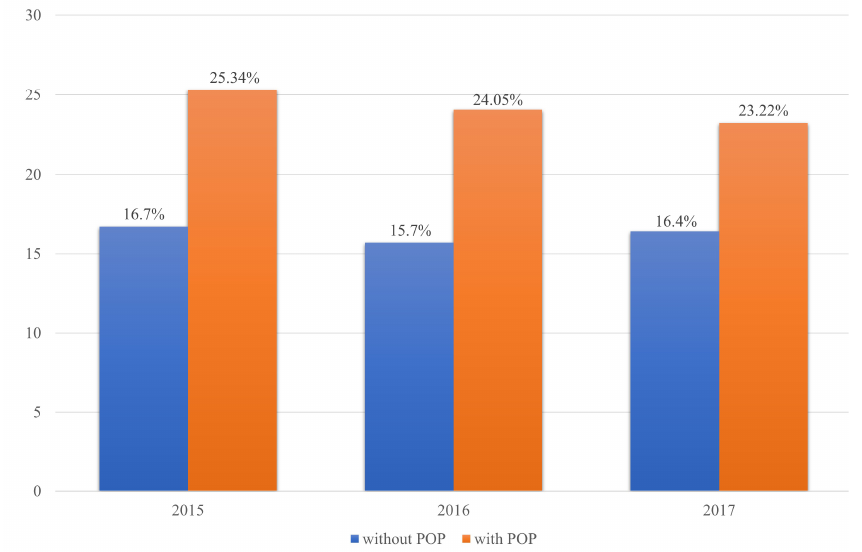
Figure 4. Prevalence of pelvic organ prolapse (POP) among women with osteoporosis aged over 50 years (1:10 age-stratified matching model; p = 0.013, 0.0009, and 0.0119 in 2015, 2016, and 2017, re- spectively).